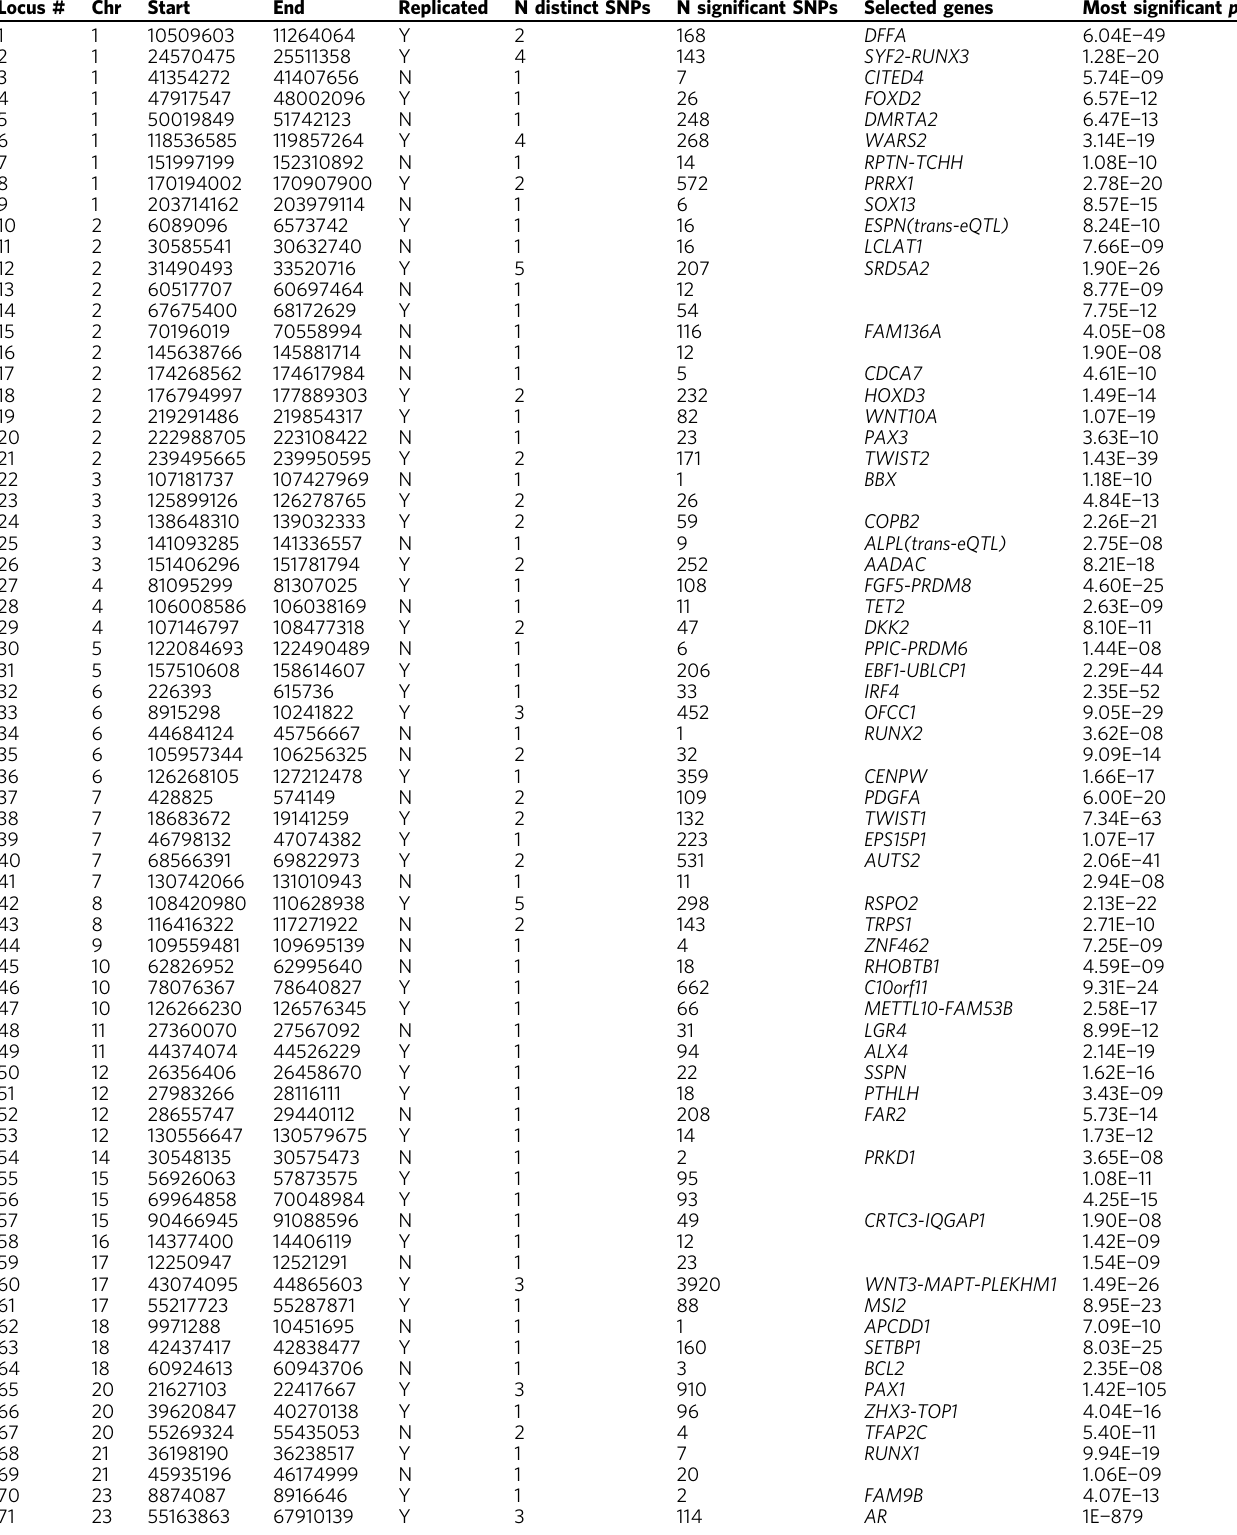
Table 1 Summary of MPB